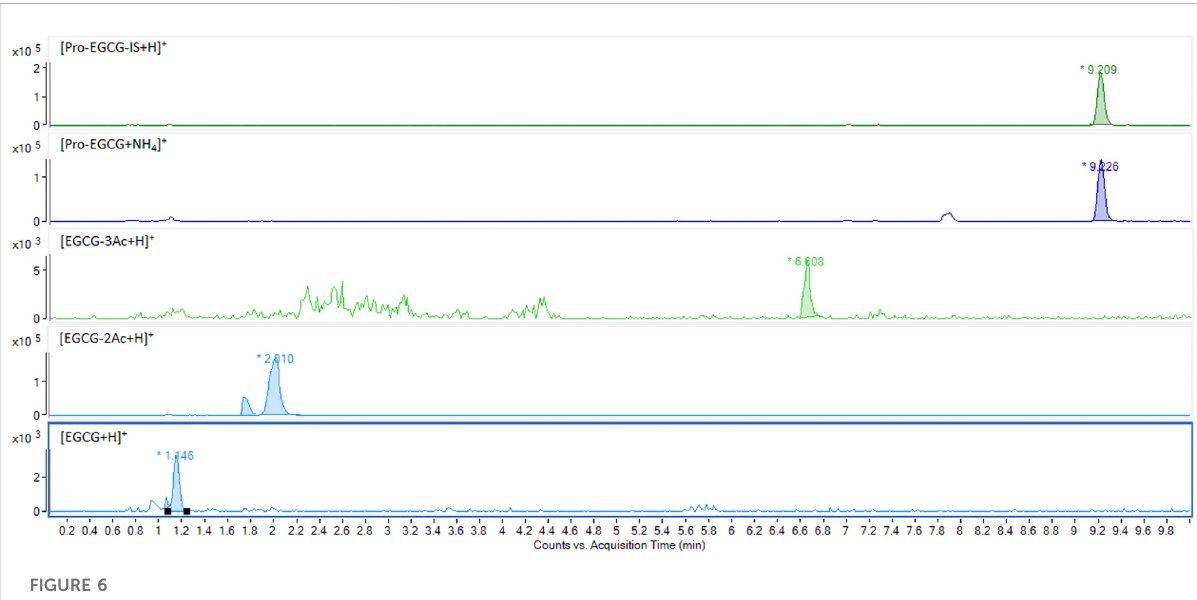
FIGURE 6 Degradation of pro-EGCG. Chromatograms showed pro-EGCG was degraded forming some typical metabolites like EGCG-3Ac and EGCG- 2Ac, and EGCG after 10 min incubation at room